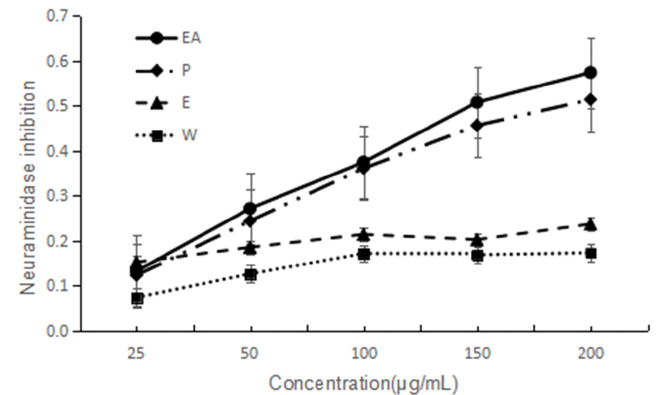
Figure 2. NA inhibitory activity of four extracts of F. dibotrys . EA: ethyl acetate fraction; P: petroleum ether fraction; E: ethanol fraction; W: water fraction.